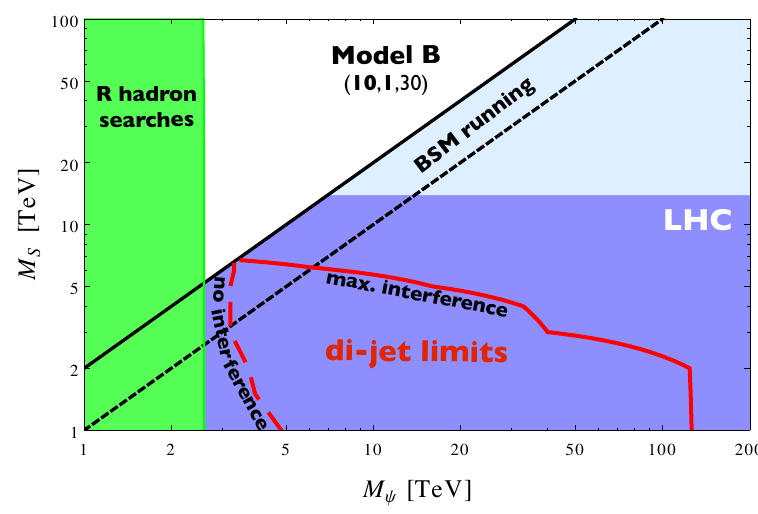
Figure 21 . Excluded regions in the M (cid:0) M S plane combining R -hadron searches (green horizontal stripe) with dijet cross section limits from ATLAS 95% C.L. [40] for the benchmark B ( R 3 = 10 , R 2 = 1 , N F = 30). Excluded regions are also given for the limiting cases of maximal interference (below red solid curve) and no interference (left of red dashed curve), with A = 100%. The dark (light) blue area indicates the searchable parameter space (5.7) at the LHC (future colliders). The strip (5.11) with M . M S < 2 M where an enhancement of (cid:11) s due to asymptotically safe running takes place corresponds to the region between the full and dashed black